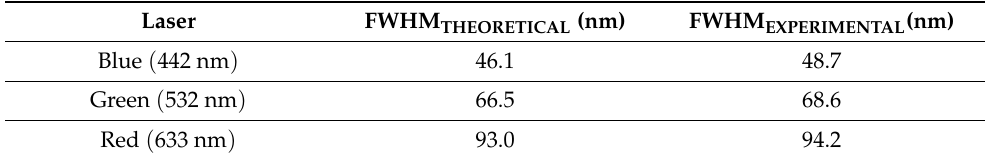
Table 3. Full width at half maximum (FWHM) for each laser, both experimental (Figure 7) and theoretical (Figure 3) measurements.